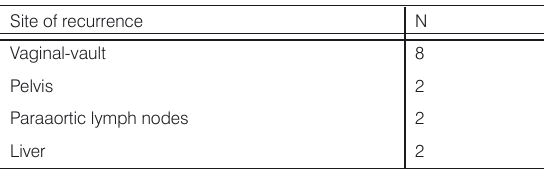
Table 3. Sites of recurrence in endometrial cancer. Table 4. Clinicopathological factors and univariate analysis for